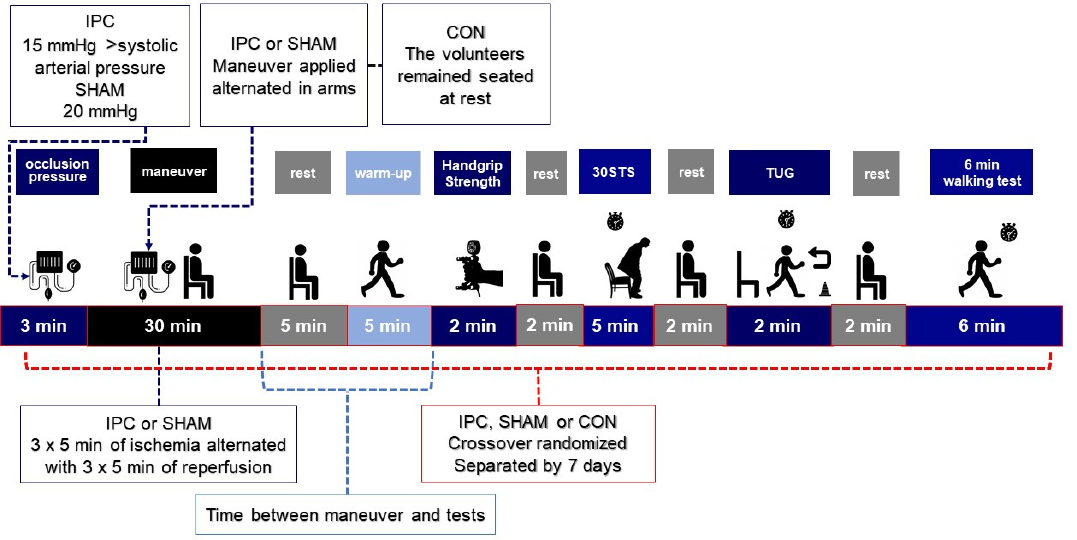
Figure 1. Experimental design; IPC: ischemic preconditioning; SHAM: placebo; CON: control protocol; TUG: timed up and go; 30STS: 30 s chair stand.